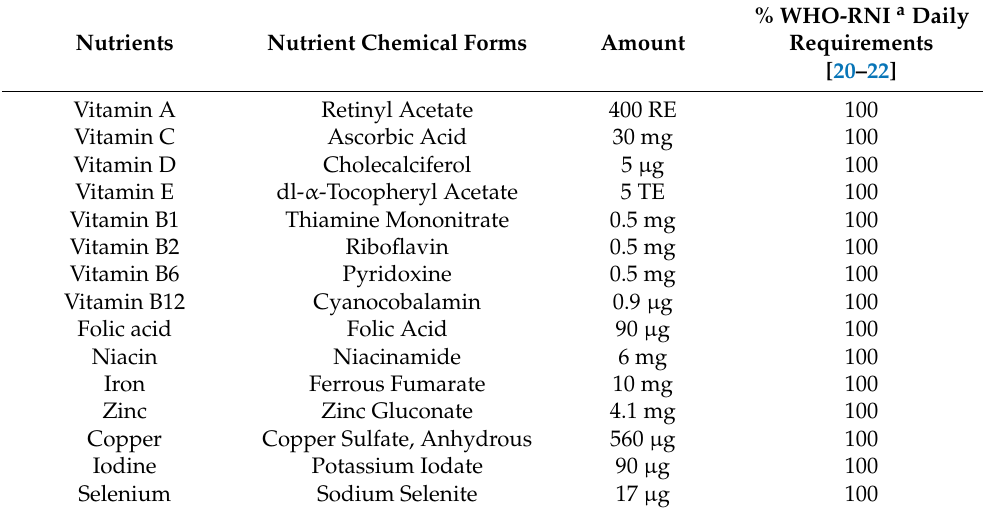
Table 1. The full contents of micronutrient supplement (amount per 1 g